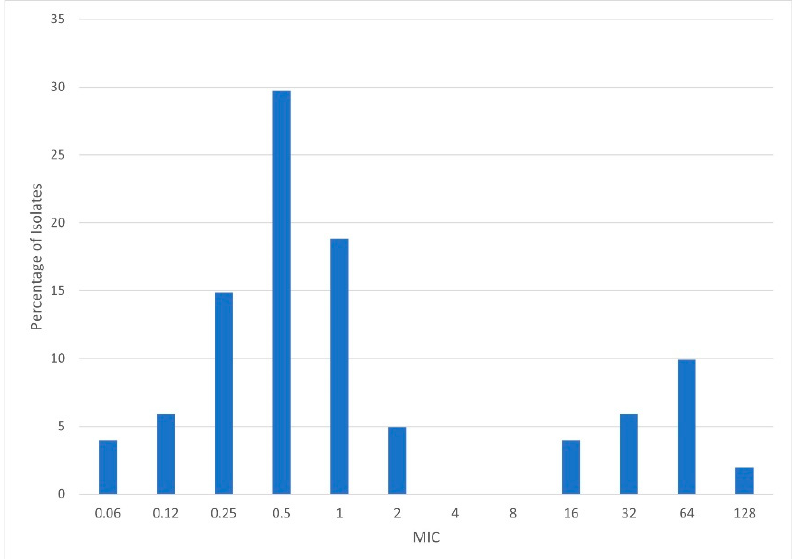
Figure 1. An example of an MIC distribution for an organism–drug combination, where the blue bars represent the percentage of isolates with each MIC in the population. The large left-hand cluster of MICs represents the wild type, and the smaller right-hand cluster represents organisms with an acquired resistance mechanism.